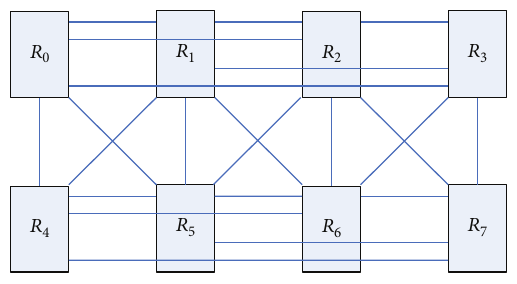
Figure 7: Path diversity of BFC network.